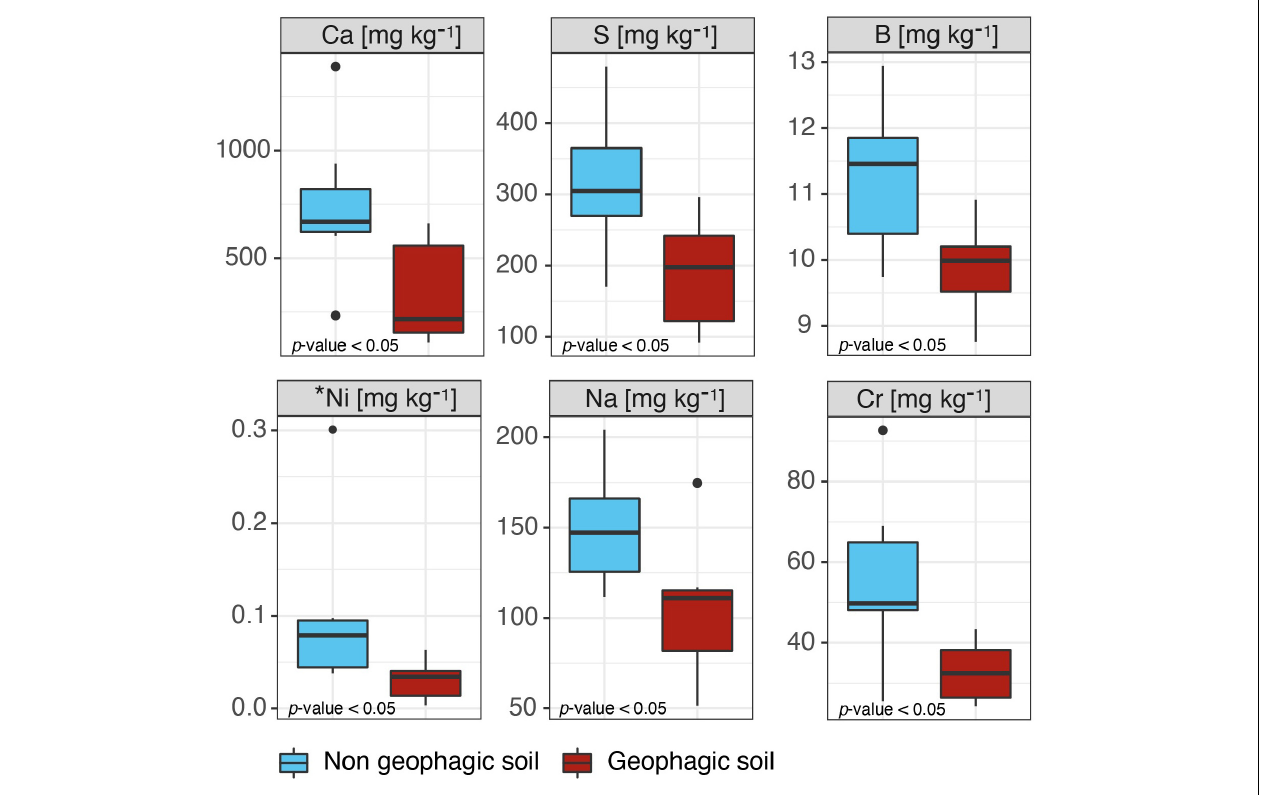
FIGURE 3 | Boxplots representing the chemical parameters resulted statistically different ( p -value < 0.05) between the geophagic and non-geophagic soils. *Available